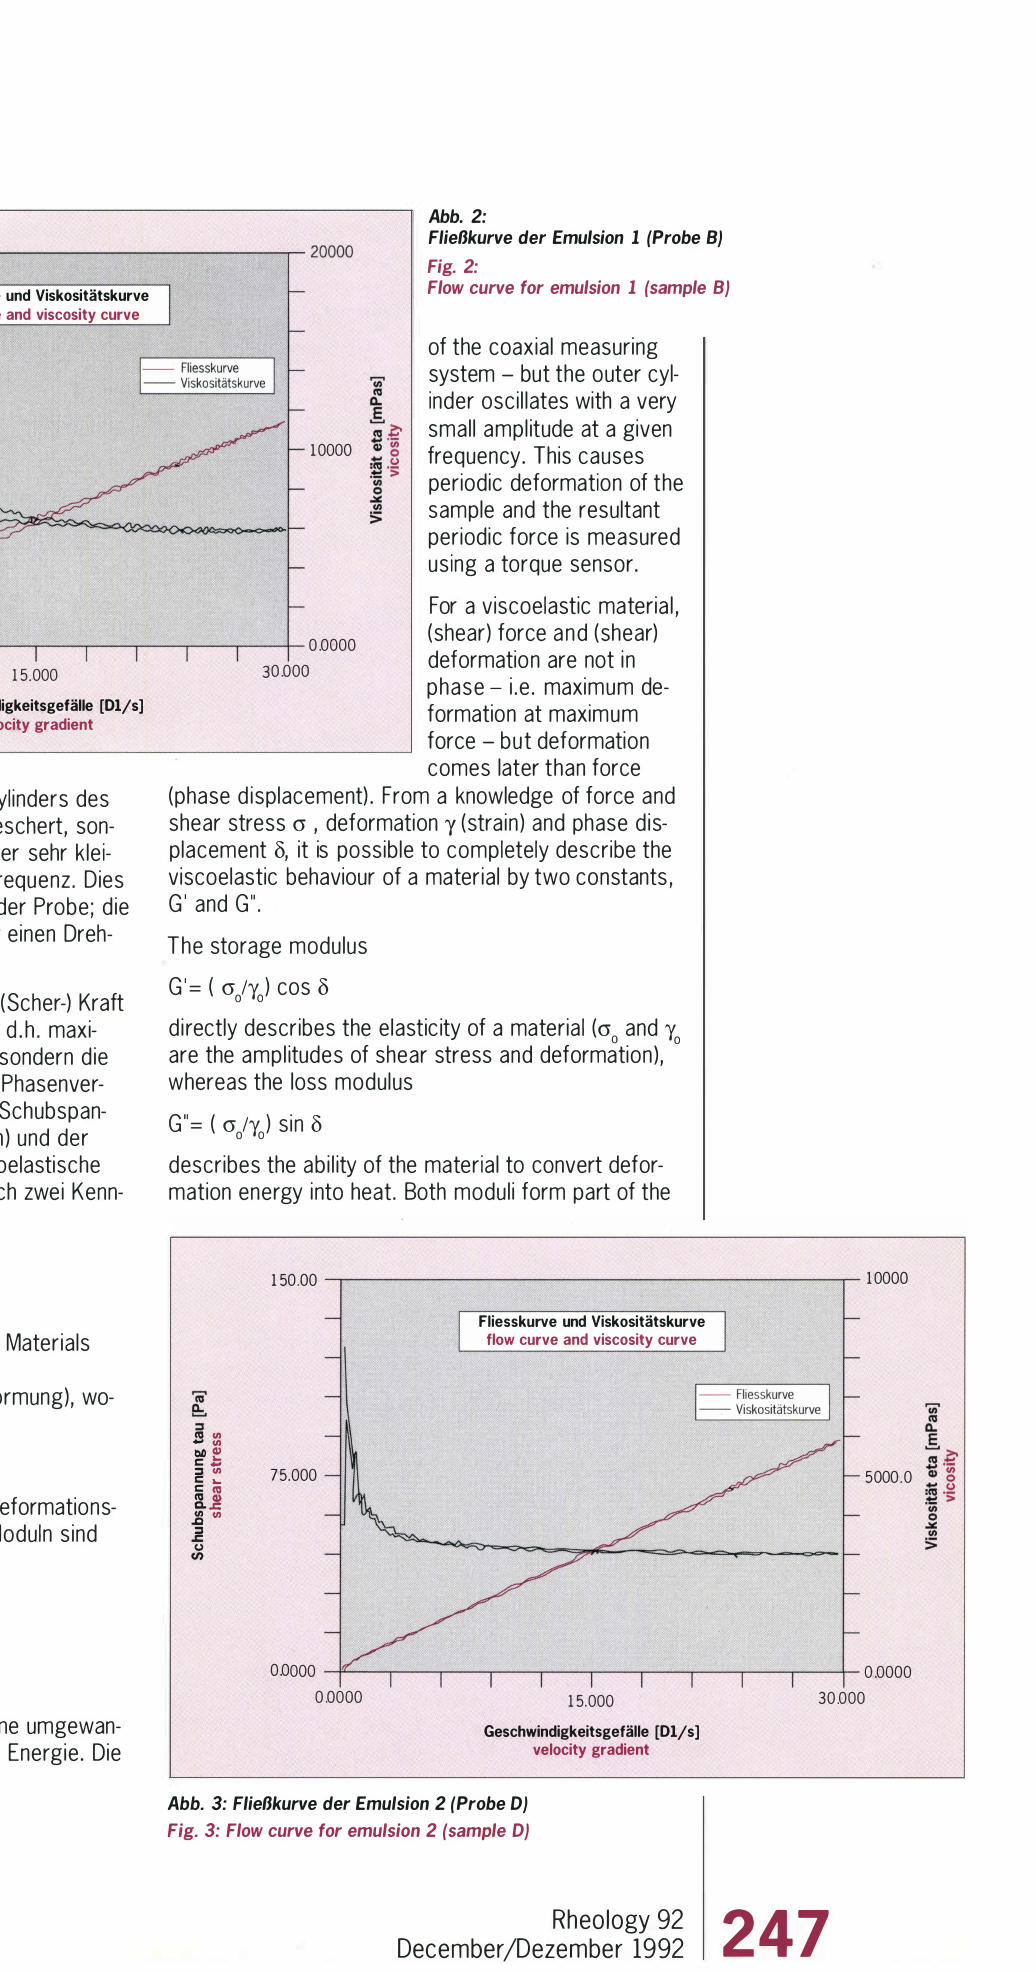
Abb. 3: Fliellkurve der Emulsion 2 (Probe D) Fig. 3: Flow curve for emulsion 2 (sample